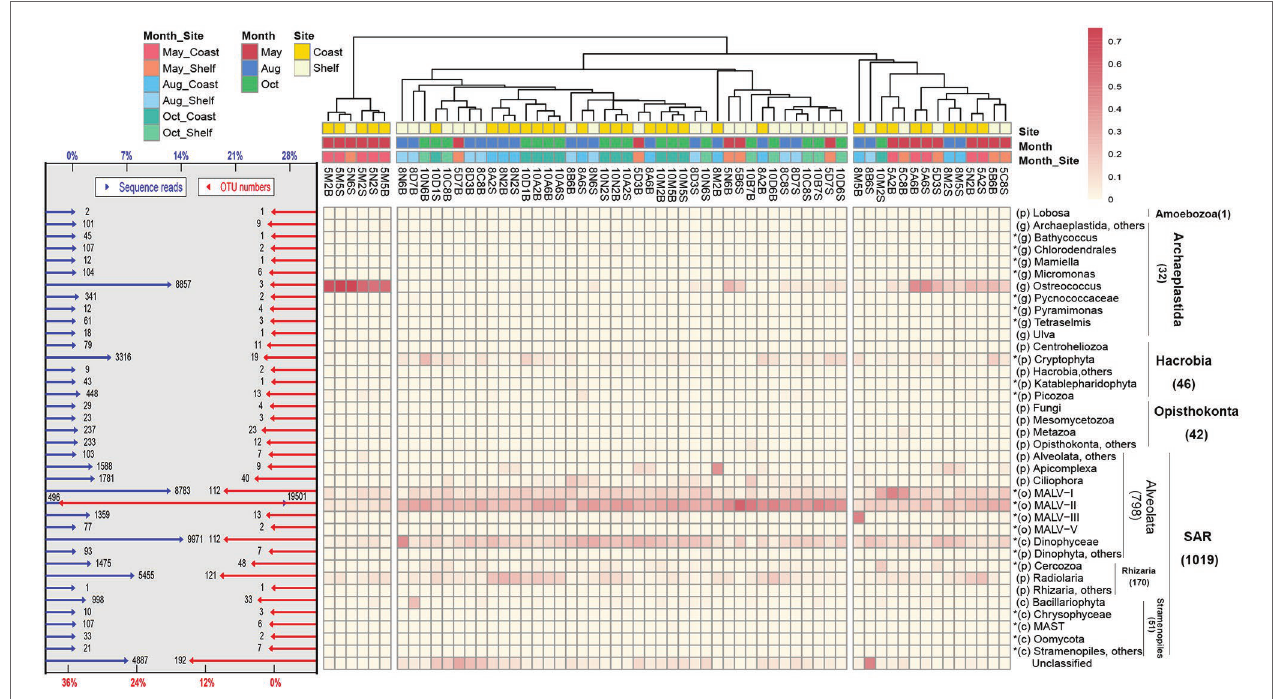
FIGURE 3 | The distribution and relative abundance of different taxonomic lineages in the entire protist community in 60 samples. The OTUs were defined at 97% sequence similarity threshold. Heatmap showed the relative abundance of the 37 lineages which were classified into seven supergroups within each sample; each of the lineages that contained more than 10 sequence reads within the entire dataset was individually presented, whereas the rare lineages (fewer than 10 sequence reads) and the undetermined lineages (sequence similarity >80%) merged as “others.” Sequence reads are “unclassified” when sequence similarity to a reference sequence is <80%. The OTU numbers are given in parentheses for each supergroup. The rank classification of each lineage is listed before with lowercase in bracket (“p” for phylum, “c” for class, “o” for order, and “g” for genus). An asterisk in front of the taxon indicates the lineages belonging to flagellates. Bar graphs in the left showed the relative abundance of sequence reads (species abundance) and OTU numbers (species richness) in the 37 branching lineages within the entire dataset (metacommunity including 60 local communities). Dendrogram on the top showed the clustering for 60 samples based on Bray-Curtis similarity. The color codes at the branch end were based on months, habitats, and both of